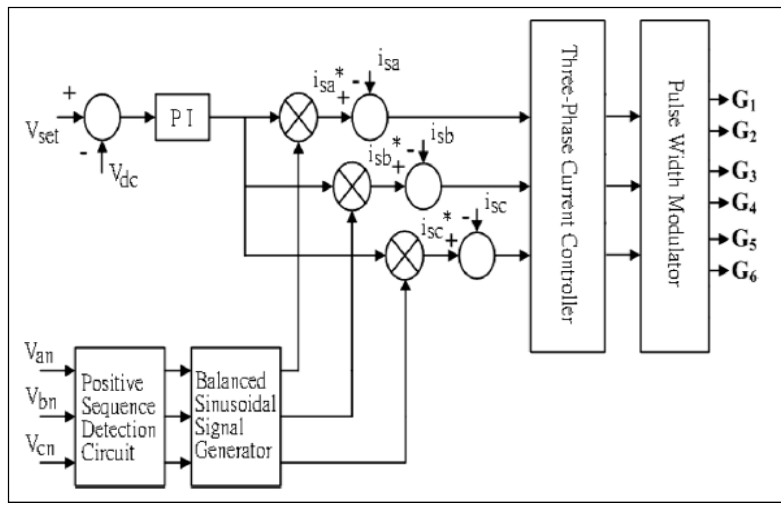
Figure 4. Block diagram of the proposed three-phase three-line active power filter.